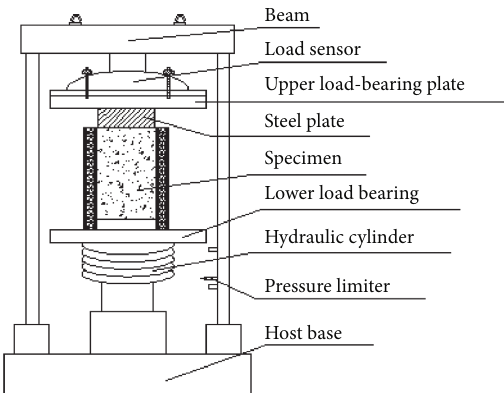
Figure 2: A schematic of the loading condition of the composite